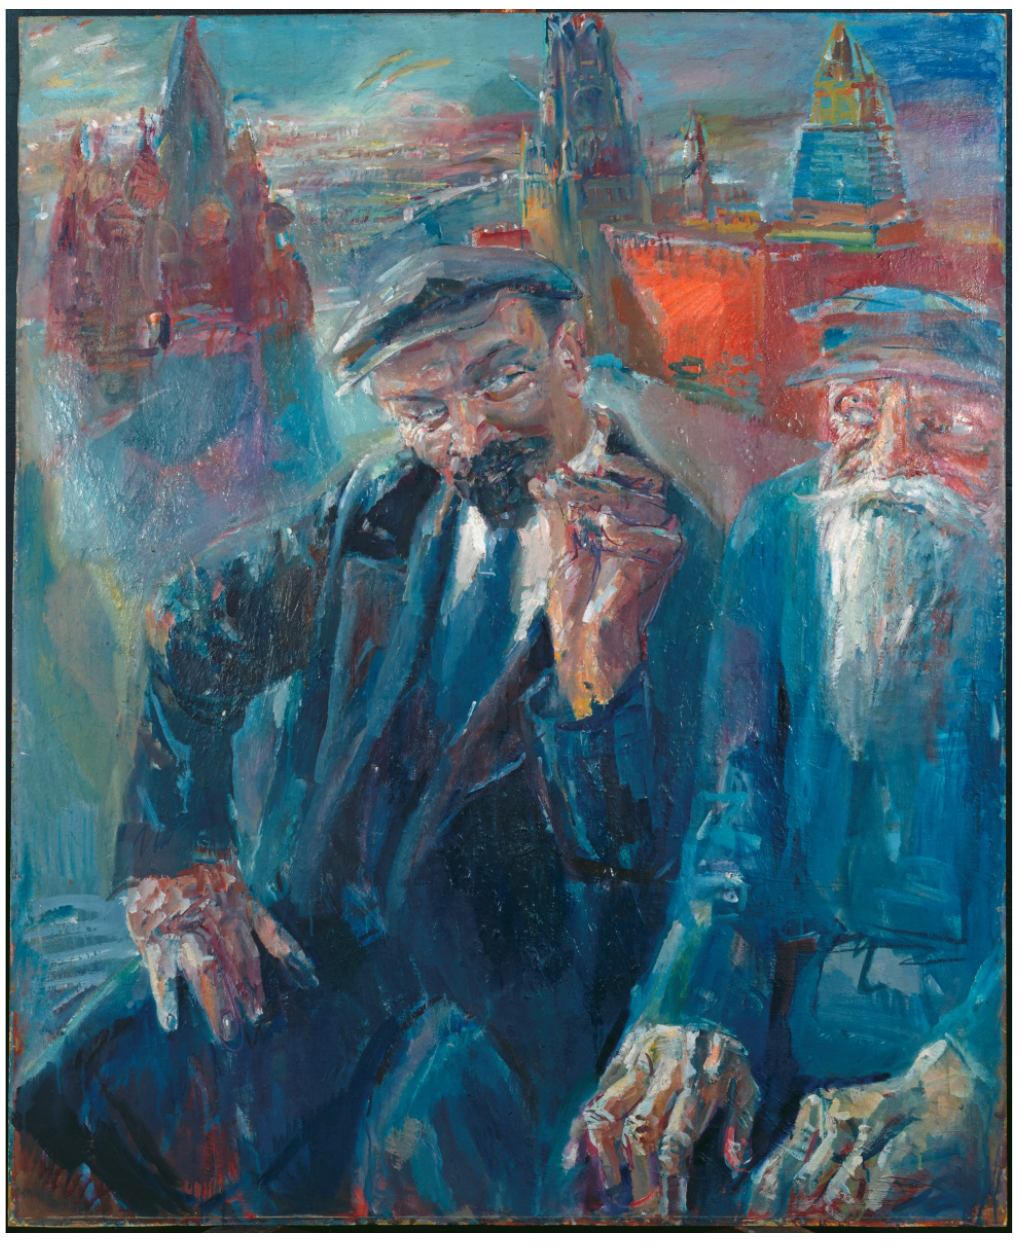
Figure 7 Bernhard Heisig, Lenin and the Incredulous Timofej , 1970. Oil on Fiberboard. 272 x 150 cm. Museum der Bildenden Künste, Leipzig. Photo Credit: bpk, Berlin/Museum der Bildende Künste, Leipzig/Ursula